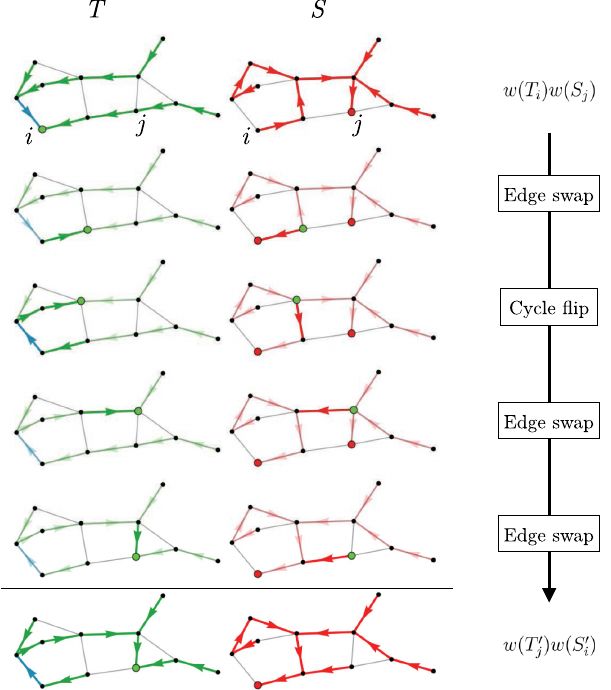
FIG. 13. Tree surgery. Illustration of the steps of the iterative tree surgery described in the proof of Lemma 1 applied to a particular pair of rooted spanning trees T i and S j of a graph G with 11 vertices. The sequence of edge swap and cycle flip operations applied has the effect of swapping the roots of the trees without swapping the distinguished edge (blue). At intermediate stages, S becomes a doubly-rooted tree whose branch point (labeled in green, also the root of T ) moves between its roots i and j (labeled in red). The set of directed edges in the final pair of trees differs from the set in the original pair by the edges in the cycle (which contains the distinguished edge) flipped in the second step.